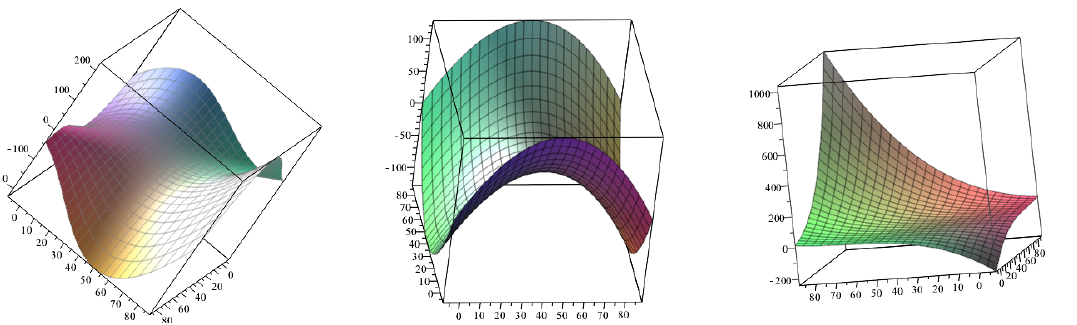
Figure 1. B-spline solutions of the second-order